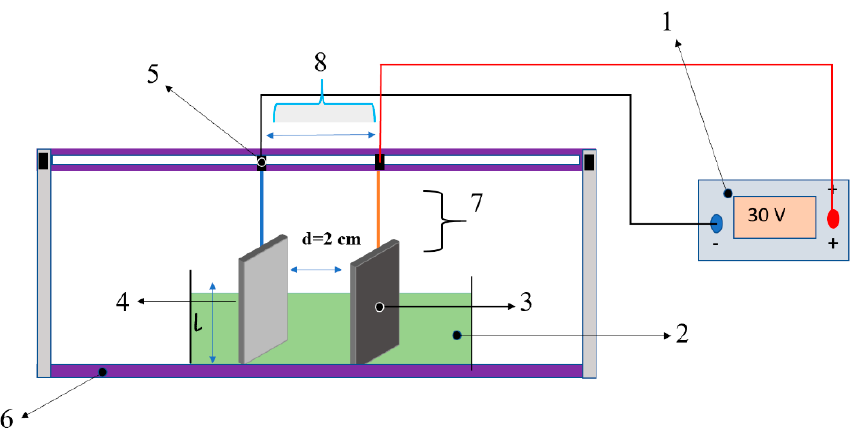
Figure 1. Schematic diagram of the EPD system set-up: 1—DC voltage source; 2—EPD ZnO solution; 3—Platinum (2 × 1 cm 2 electrode); 4-silicon substrate; 5—connectors; 6—EPD base; 7—adjustable contact length of electrodes within the electrolyte; 8—adjustable distance between electrode and substrate.